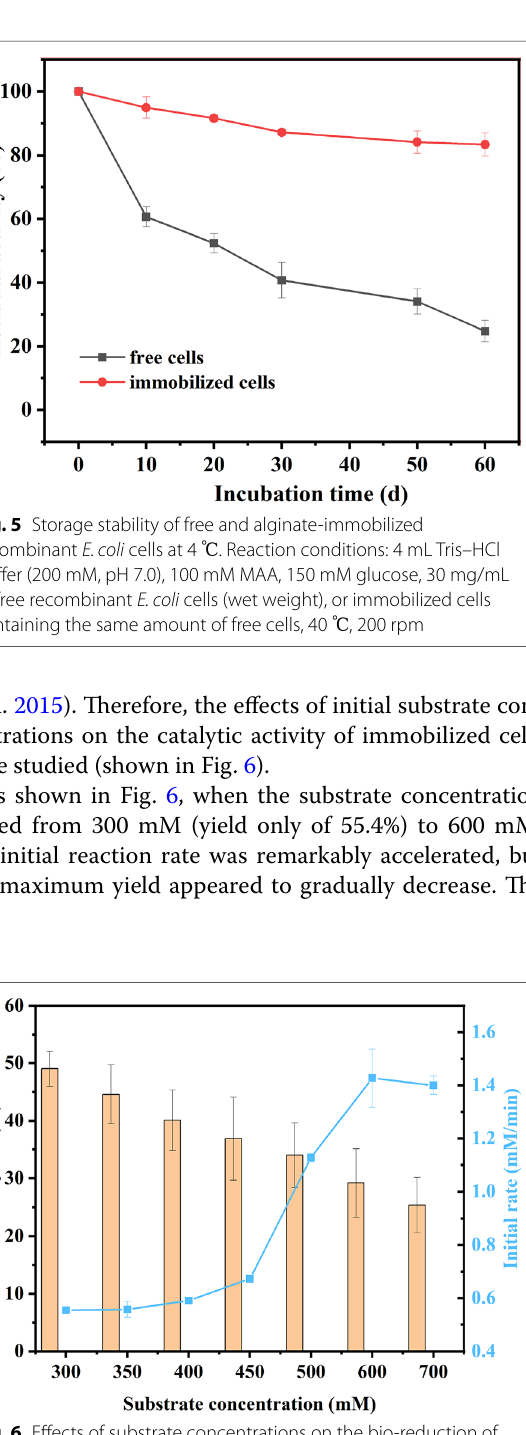
Fig. 6 Effects of substrate concentrations on the bio‑reduction of MAA to ( R )‑HBME with alginate‑immobilized recombinant E. coli cells. Reaction conditions: 4 mL Tris–HCl buffer (200 mM, pH 7.0), 800 mM glucose, different concentrations of MAA (300, 350, 400, 450, 500, 600, 700 mM), 30 mg/mL free recombination E. coli cells (wet weight), or immobilized cells containing the same amount of free cells, 40 ℃ , 200 rpm; ( n 3, different lowercase letters represent significant = differences between groups, p <